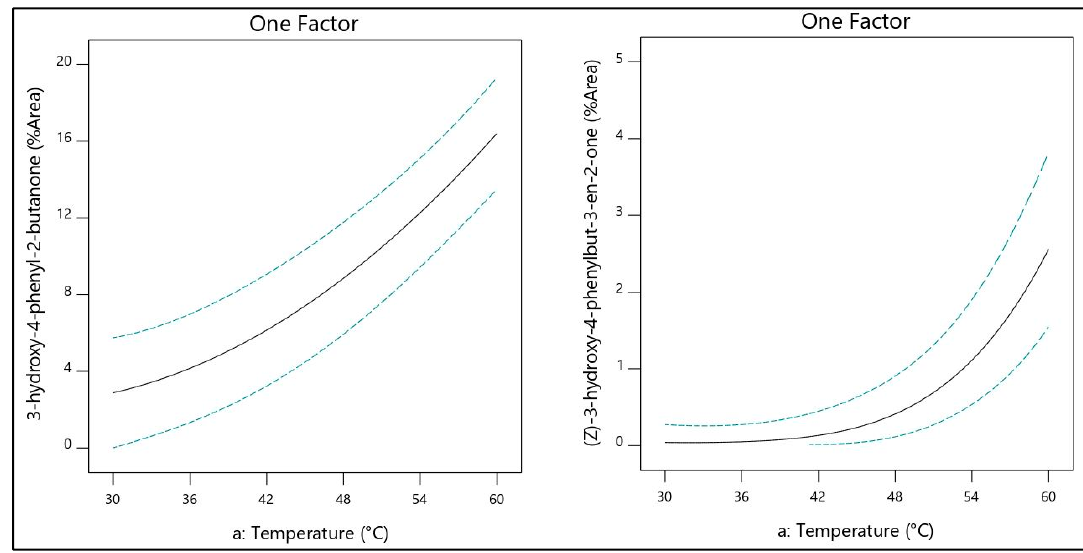
Figure 2. Temperature effect in the isolation of 3-hydroxy-4-phenyl-2-butanone, and ( Z )-3-hydroxy-4-phenylbut-3-en-2- one.